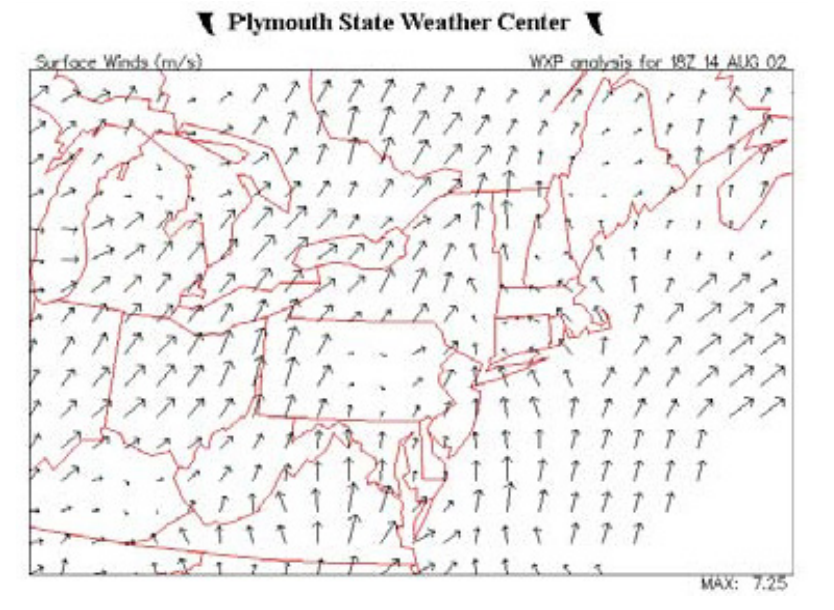
Figure 9. Surface winds (m/s) at 18Z on 14 August 2002 from Plymouth State Weather